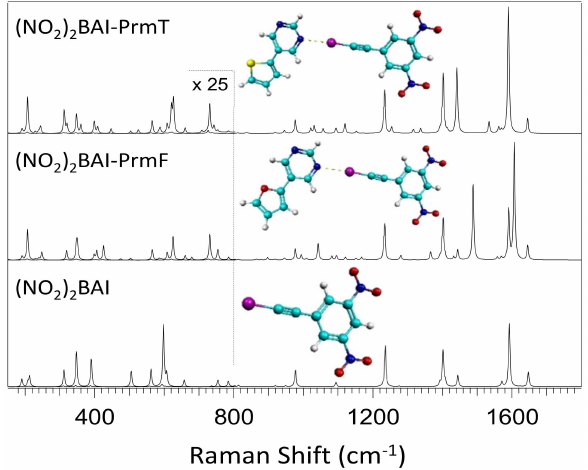
Figure 11. Simulated Raman spectra of (NO 2 ) 2 BAI (bottom), and optimized complexes formed from (NO 2 ) 2 BAI with either PrmF (middle) or PrmT (top). Raman activities below 800 cm − 1 have been multiplied by a factor of twenty-five so that they can be easily visualized.